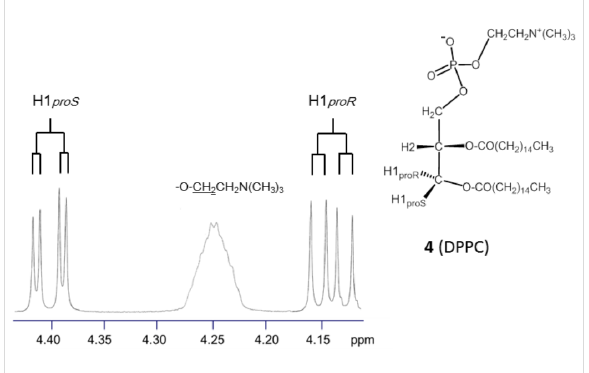
Figure 4: Partial 1 H NMR spectrum of 4 in a mixture of CDCl 3 and methanol- d 4 (C/M = 10:1,